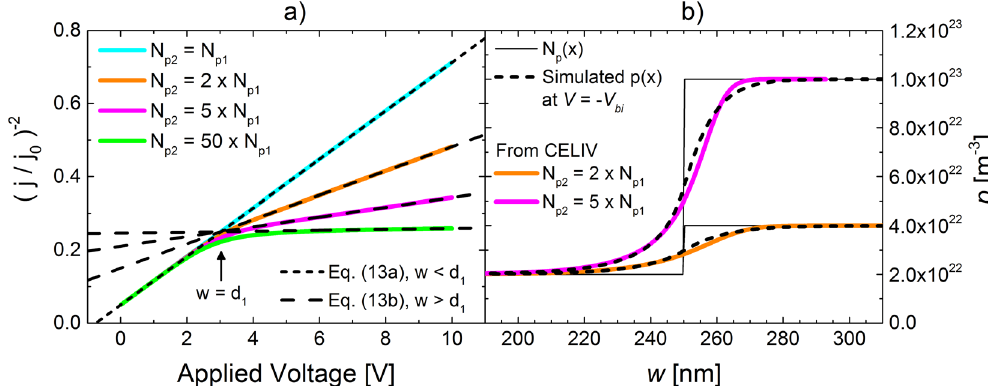
Figure 3. ( a ) Simulated capacitive CELIV current transients for a device with a step profile with different steps where = N x N ( ) for 0 < x < d 1 , = N x N ( ) for d 1 < x < d , where d 1 = 250 nm and N p1 = 2 × 10 22 m − 3 . ( b ) The p p 1 p p 2 carrier-density profiles as extracted from the CELIV current transients, using Eq. (11) and Eq. (10), are depicted by the colored lines. For comparison, the actual quasi-equilibrium hole densities p ( x ), simulated at V = − V bi , are depicted by the dashed lines; the corresponding input concentration of ionized dopants N p ( x ) is indicated by the thin black lines.